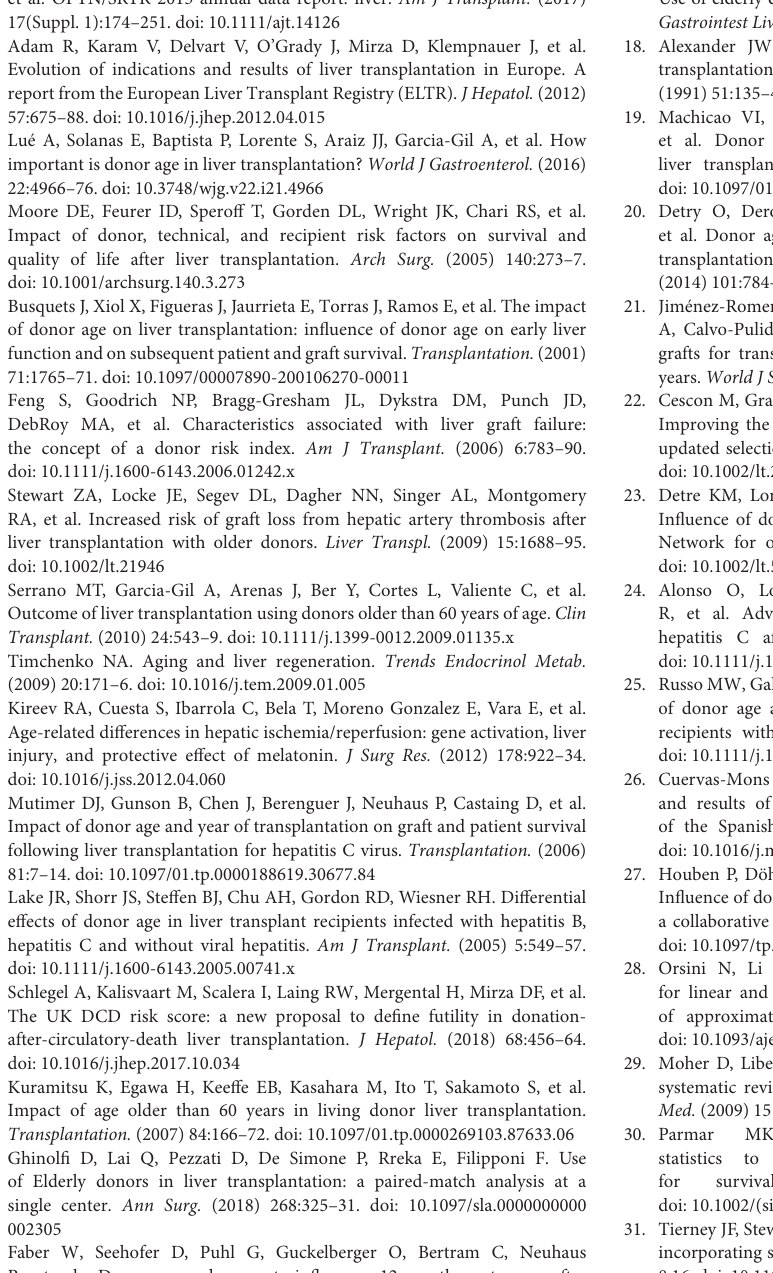
bias of continuous risks of GF; P for egger’s test = 0.98. (B) Begg’s funnel plot on publication bias of continuous risks of patient death; P for egger’s test = 0.05.